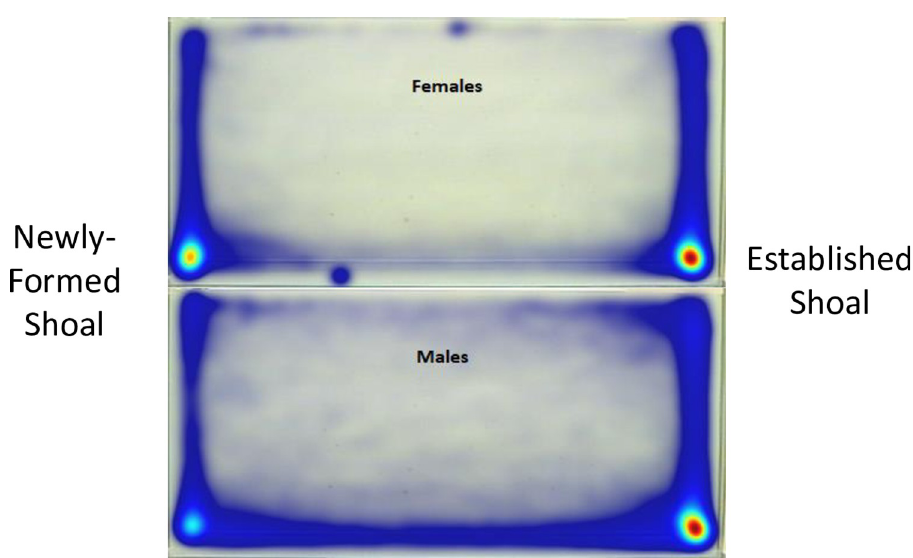
Fig 2. Heatmaps collapsed across trials with the same configuration of stimuli. Warm colors indicate highest intensities of localization while cooler colors indicate lowest intensities of